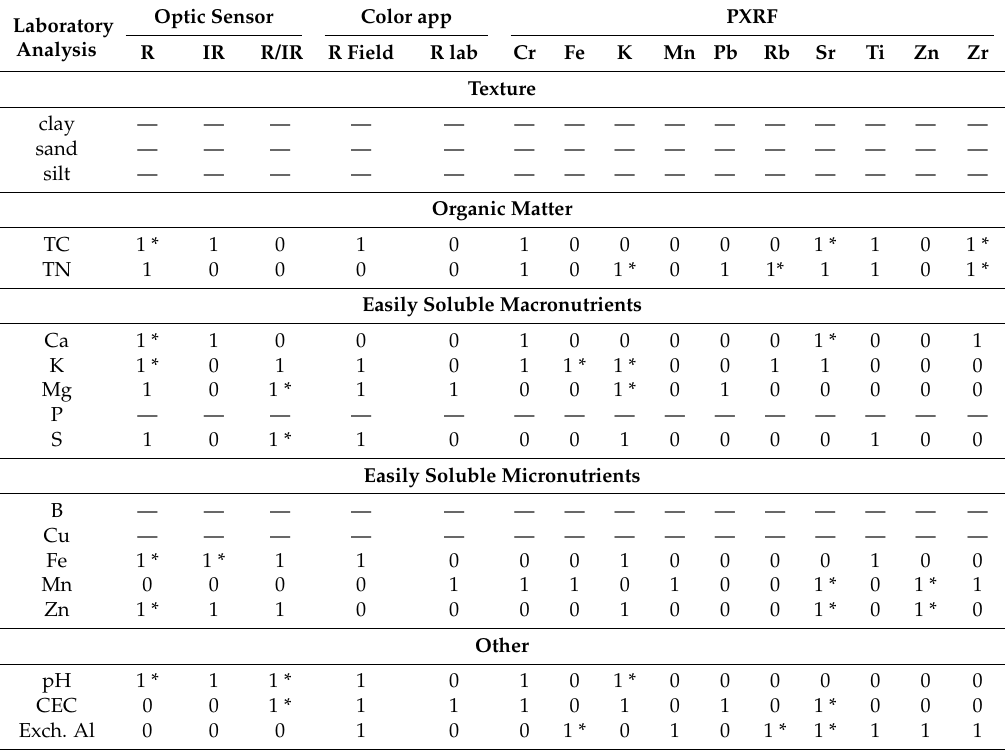
Figure 5. Results from the leave-one-site-out validation. The bars show E and r 2 -values for one of the five best models for each response variable (included predictors indicated by a star in Table 4). The dotted bars show the modeling efficiency. The plain filled bars show the coefficient of determination for a linear regression between predicted and measured values. TC = total carbon, TN = nitrogen, and CEC = cation exchange capacity. The red line indicates r 2 = 0.5 or E = 0.5 (the screening criteria for relevance and accuracy). MAE = mean absolute error. The units of the MAEs are found in Table 1. Table 4. Predictors included in at least one of the five best models for each response variable are marked 1, as judged by the sum of the ranks of r 2 , E, and MAE for the leave-one-site-out validations. Predictor variables that were not included among the best are denoted 0. Prediction models with an E-value < 0.5 were considered non-functional and were thus omitted from the present summary, as well as from any further analyses. The stars (*) indicate that the predictor was included in the best model (the one of the five best models that had the highest number of measurements above the detection limit), for which a more detailed presentation of the validation results is found in Figure 5. CEC = cation exchange capacity; R = red, IR = infrared; TC = total carbon; N = nitrogen; Exch. Al = exchangeable Al; --- = no working prediction model for this soil property. The red reflectance (R) value of the optic mapper was a 20 nm band centered on 660 nm and the R value of the app was the broad red band of the mobile phone camera.